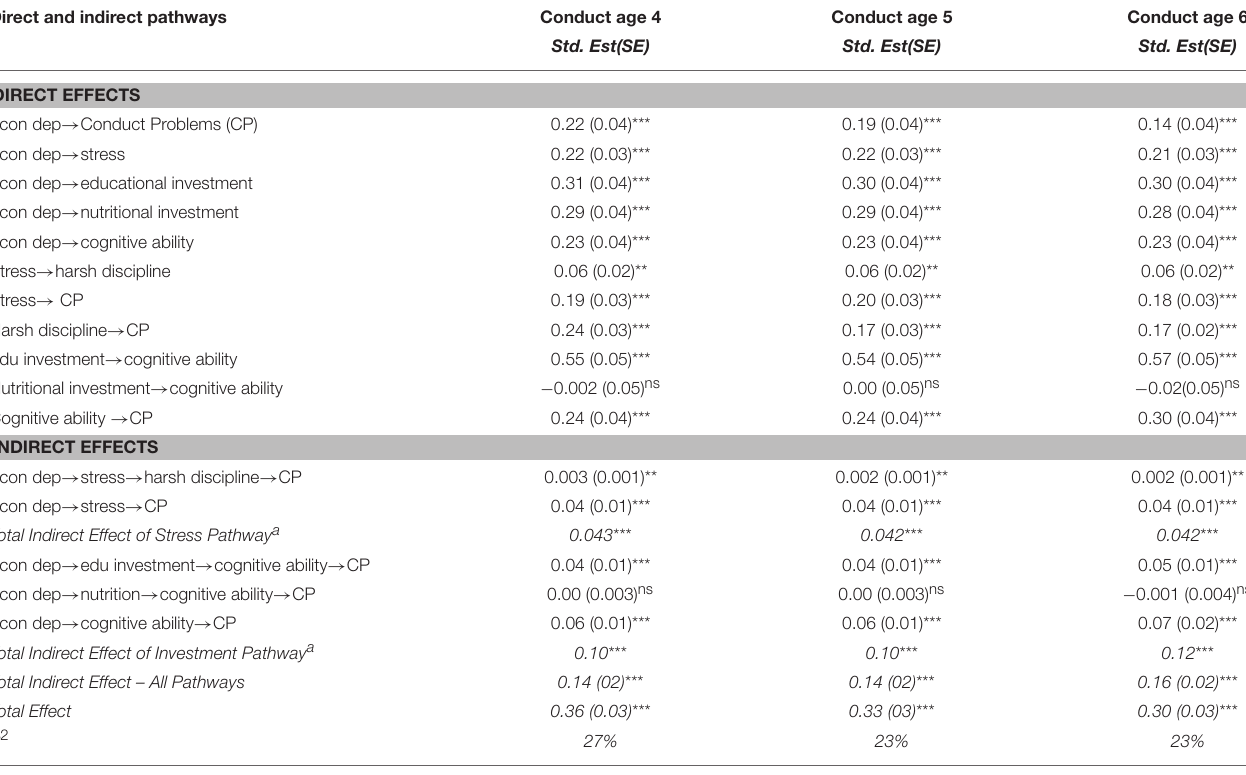
TABLE 5 | Standardized direct and indirect effects (via family stress and investment variables) of economic deprivation on trajectory of conduct problems. Direct and indirect